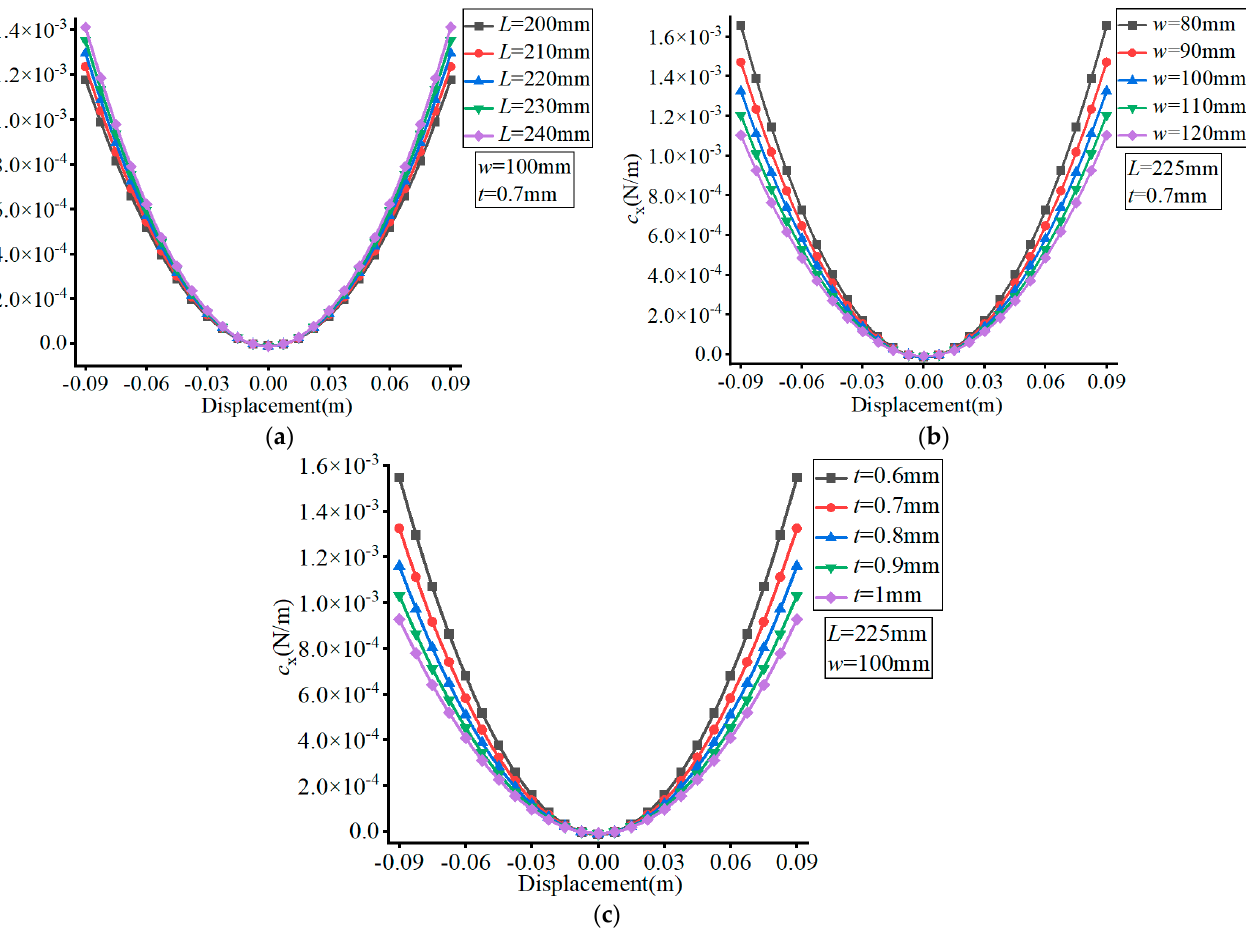
Figure 7. Effect of structural parameters on c x . ( a ) Effect of L ; ( b ) Effect of w ; ( c ) Effect of t .